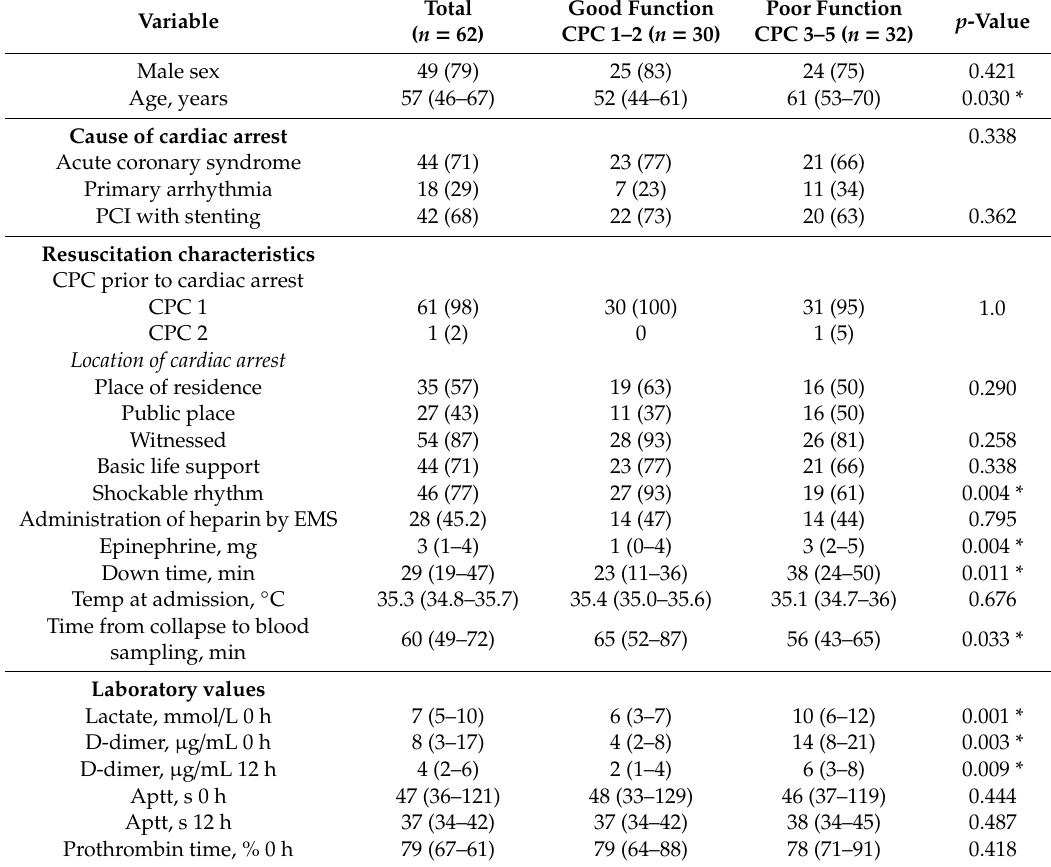
Table 1. Patient characteristics according to neurologic function on day 30. Data are n (%) or median (25–75% interquartile